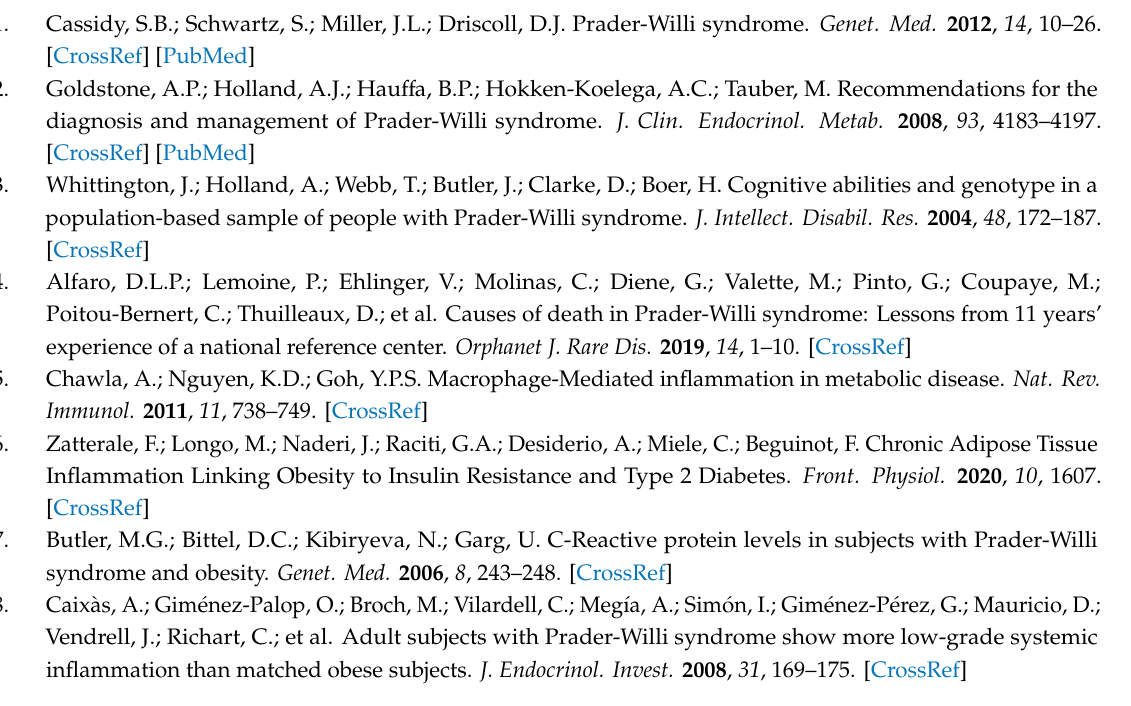
Table S1: Correlations simple and after adjusted for gender, BMI, and waist circumference among PhA and hs-CRP levels with age and anthropometric measurements in control